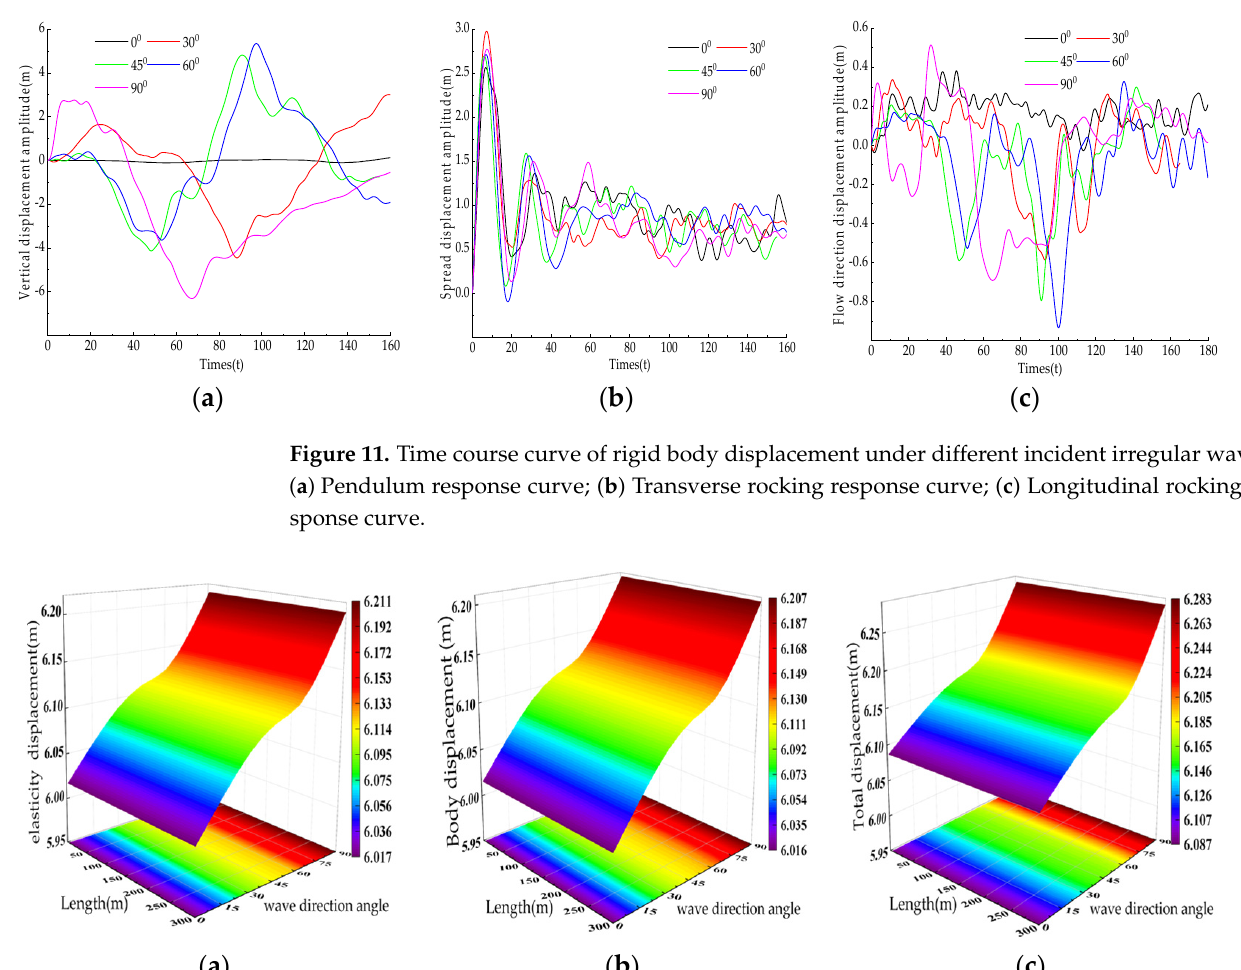
Figure 11. Time course curve of rigid body displacement under different incident irregular waves. ( a ) Pendulum response curve; ( b ) Transverse rocking response curve; ( c ) Longitudinal rocking re-